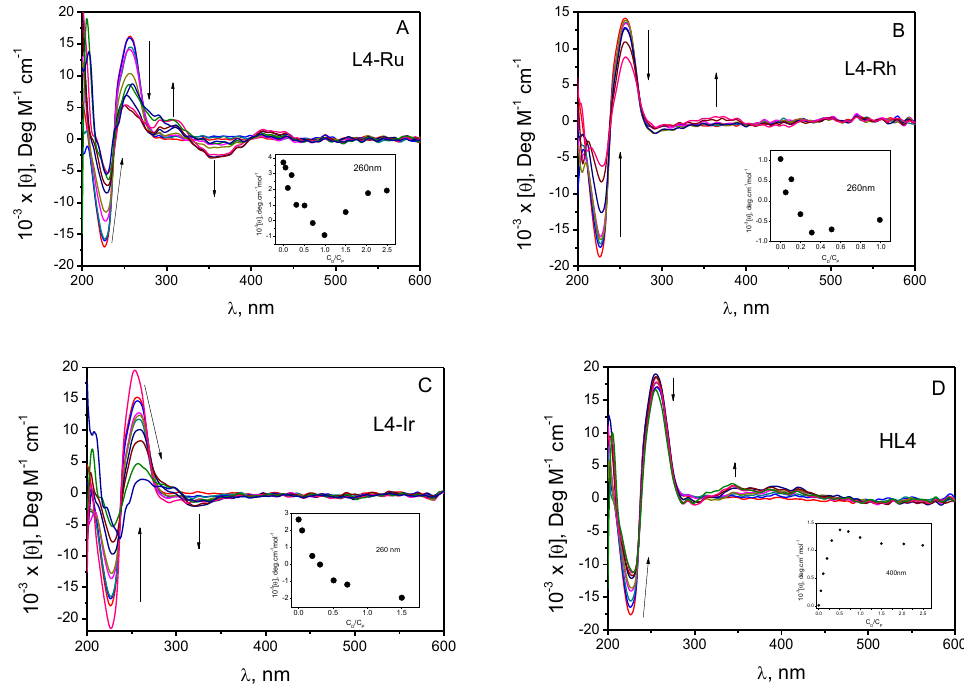
Figure 6. CD spectra for ( A ) L4-Ru /DNA, ( B ) L4-Rh /DNA, ( C ) L4-Ir /DNA and ( D ) HL4 /DNA recorded with increasing drug concentration (arrow sense). C P = 5.73 × 10 − 5 M, C D /C P = 0–2.5. Inset: dependence of the molar ellipticity at 260 nm on the C D /C P ratio.